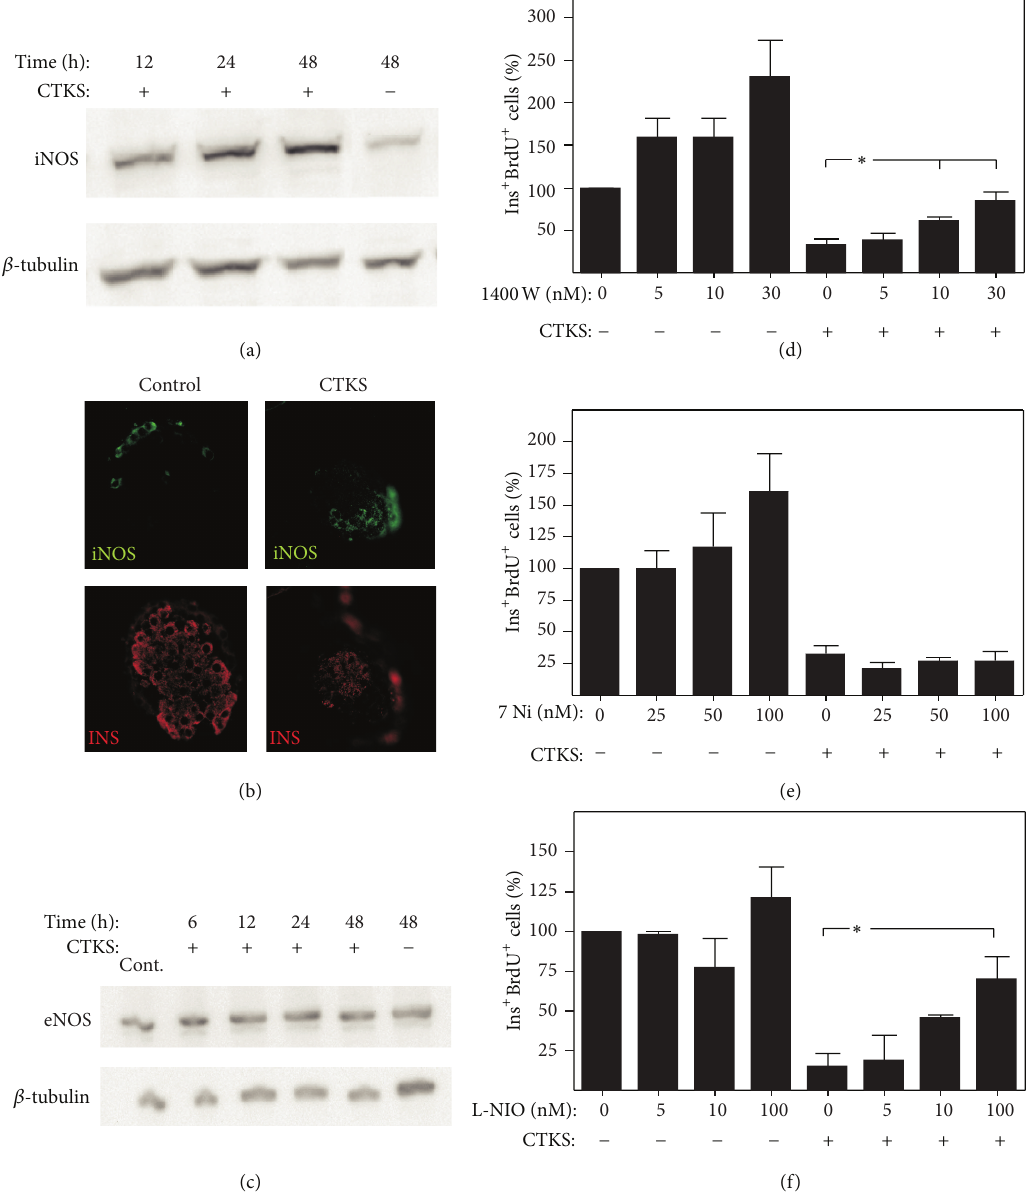
Figure 4: Role of different NOS isoforms in cytokine-induced antiproliferation in cultured 𝛽 cells. (a) and (c) iNOS and eNOS expression was assessed using western blot analysis in pancreatic islets cultured over 48 h under basal conditions and treated with a mixture of cytokines IL-1 𝛽 (50U/mL) + IFN- 𝛾 (1000U/mL) + TNF- 𝛼 (1000U/mL) (CTKS) over 6, 12, 24, and 48 h. A representative image is shown (Cont: positive brain control in eNOS Western blot). (b) Representative image of iNOS (green) and insulin (red) immunostaining of control and cytokines treated (CTKS) pancreatic islets cultured over 48 h. (d), (e), and (f) rat islets cultured over 48h in the presence of 7 Ni (e), 1400W (d), and L- NIO (f) alone or with the mixture of cytokines (CTKS). Results are presented as percentage means ± SEM of combined BrdU/insulin-positive cells relative to insulin-positive cells in a minimum of 5 experiments. ∗ 𝑃 < 0.05 treated versus